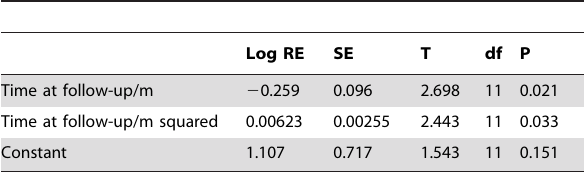
Table 3. Final model of modifiers when restricted to those studies with a contemporary control group.